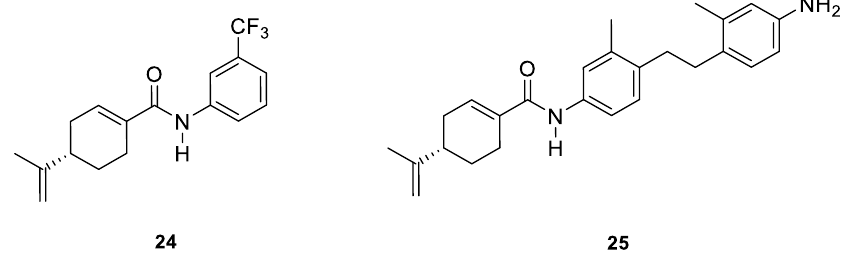
Figure 12. Selected N -arylamide derivatives of ( S )-perillic acid.